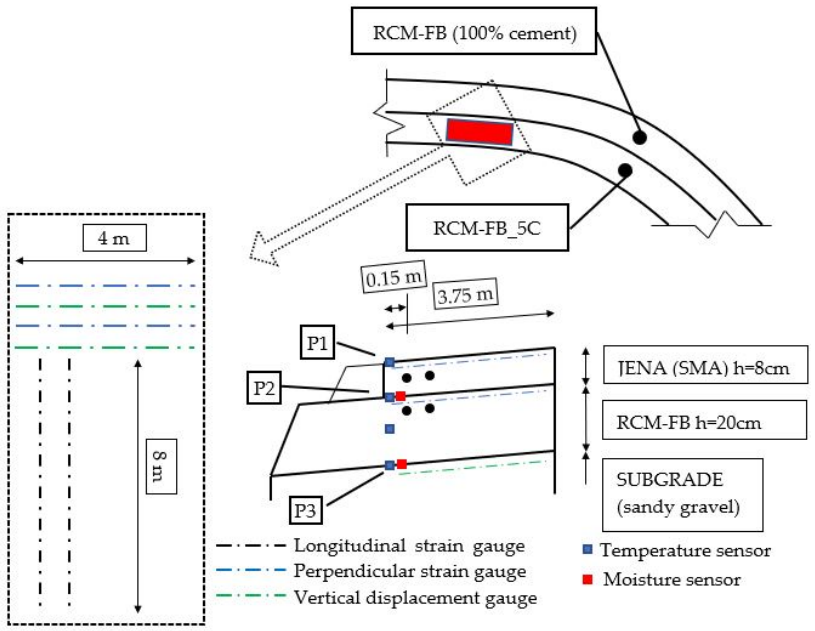
Figure 4. Schematic diagram of the monitoring sensor arrangement.